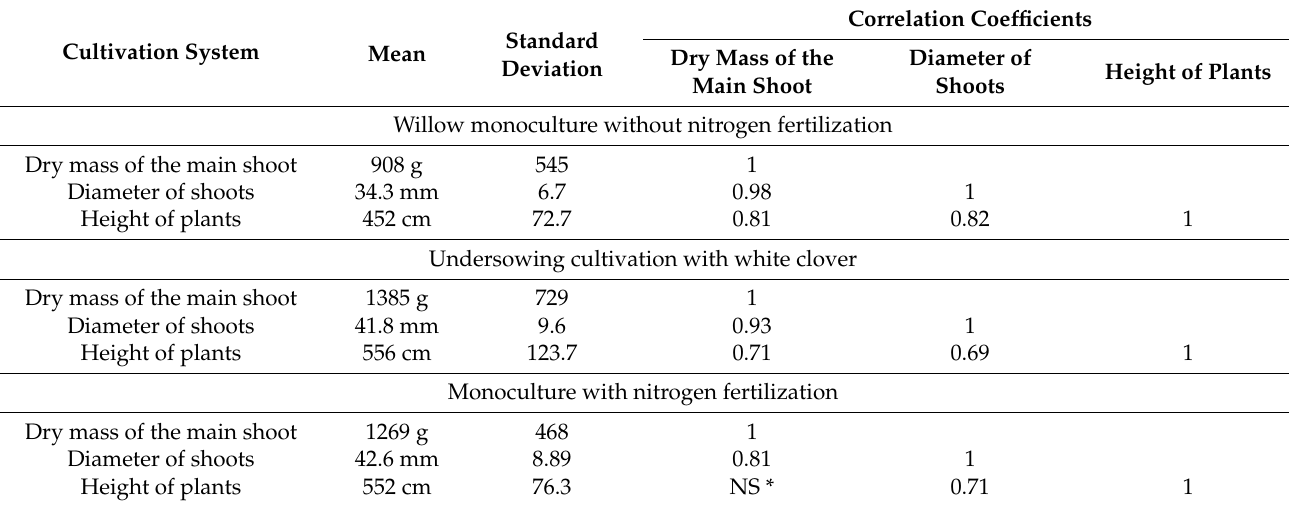
Table 8. Correlation coefficients for the analyzed traits (for the cultivation system) in